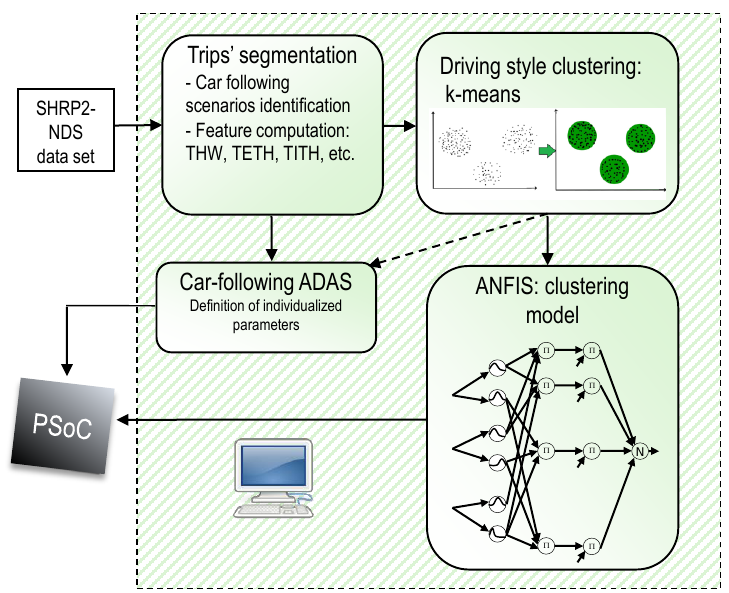
Figure 1. Offline sequence of tasks involved in the design and development of a neuro-fuzzy sensor for advanced driving-assistance system (ADAS)